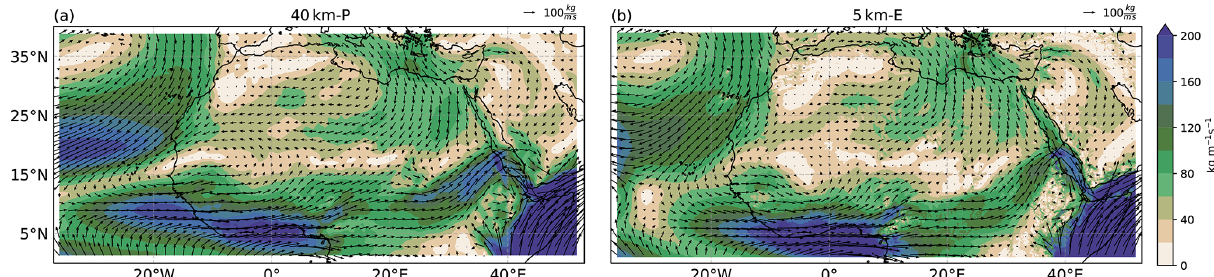
Figure 9. JAS 1000 to 850hPa vertically integrated moisture flux magnitude (shading) and mean vertically integrated moisture flux (vectors; kgm − 1 s − 1 ) for the 40km-P (a) and the 5km-E (b)